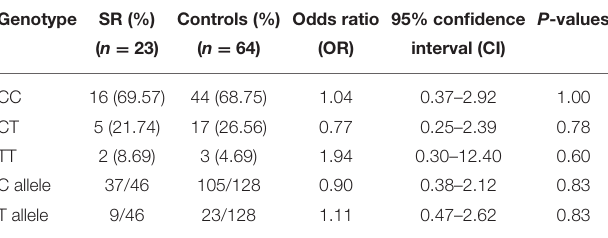
TABLE 7 | Comparison of IL-4 gene polymorphism genotype and allele frequencies between Steroid Resistant (SR) patients and controls. Genotype SR (%) Controls (%) Odds ratio 95% confidence P -values